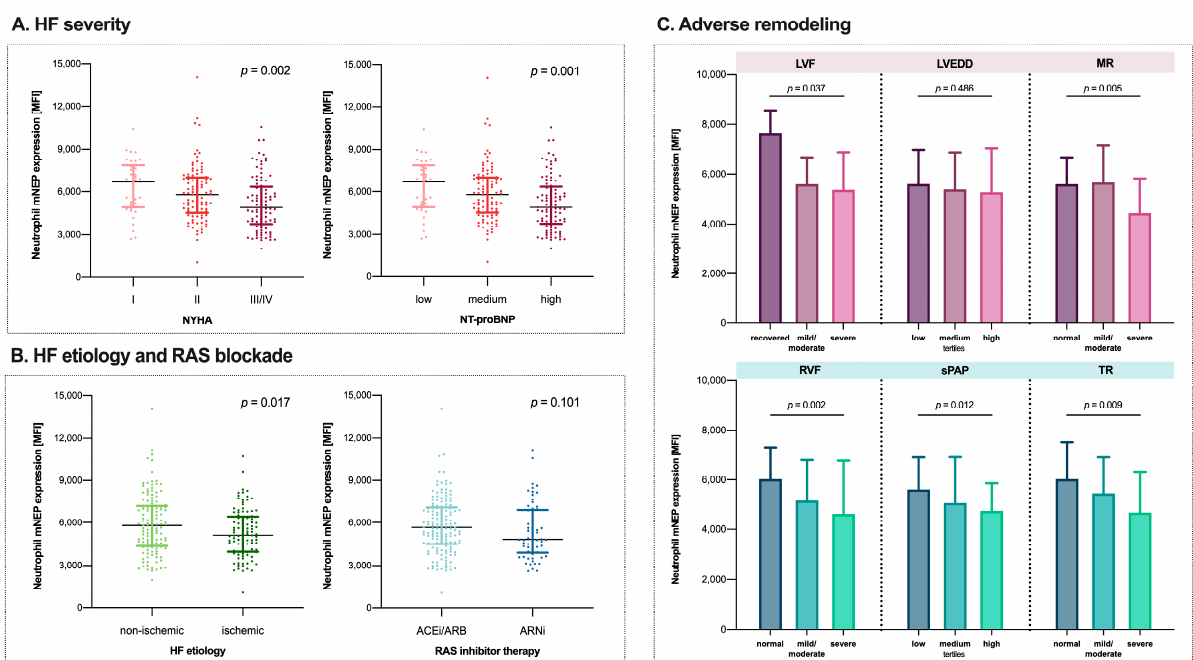
Figure 2. Relationship of neutrophil membrane-associated neprilysin (mNEP) expression with heart failure (HF) severity, reflected by ( A ) New York Heart Association (NYHA) class and tertiles of N-terminal pro-brain natriuretic peptide (NT- proBNP), ( B ) HF etiology (non-ischemic vs. ischemic) and renin-angiotensin-system (RAS) inhibitor therapy, and ( C ) adverse remodeling indicated by echocardiographic indices of left heart function and right heart function. Comparison between groups was assessed by using the Kruskal–Wallis test, levels of significance are indicated in the respective plots. The respective plots display individuals values as well as median and interquartile range. LVF—left ventricular function; LVEDD—left ventricular end-diastolic diameter; MR—mitral regurgitation; RVF—right ventricular function; sPAP—systolic pulmonary artery pressure; TR—tricuspid